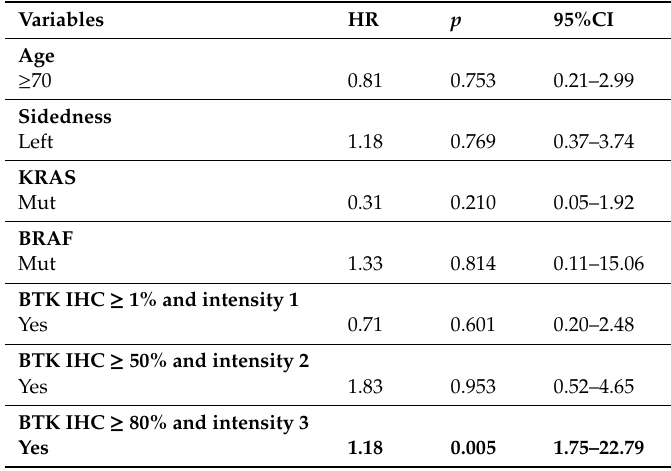
Table 4. Univariate analysis of disease-free survival (DFS).